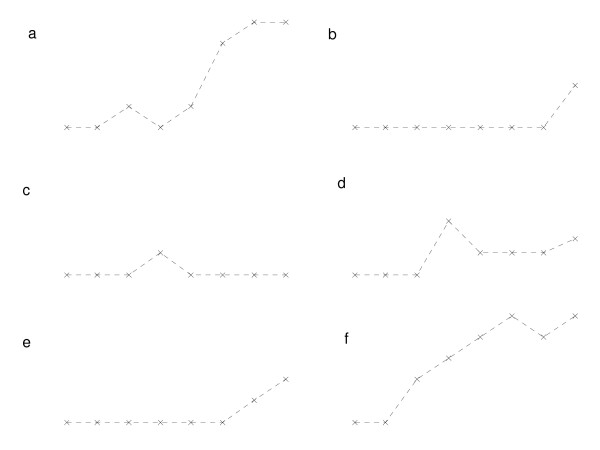
Proportion of pigs seropositive by age for six seropositive herds that had completely seronegative young stock and only used homebred gilts. x axis = Age of pigs or parity of sow (from left to right: 8 weeks, 14 weeks, gilts, parity 1, parity 2, parity 3, parity 4, parity 5+), y axis = Proportion of pigs seropositive.